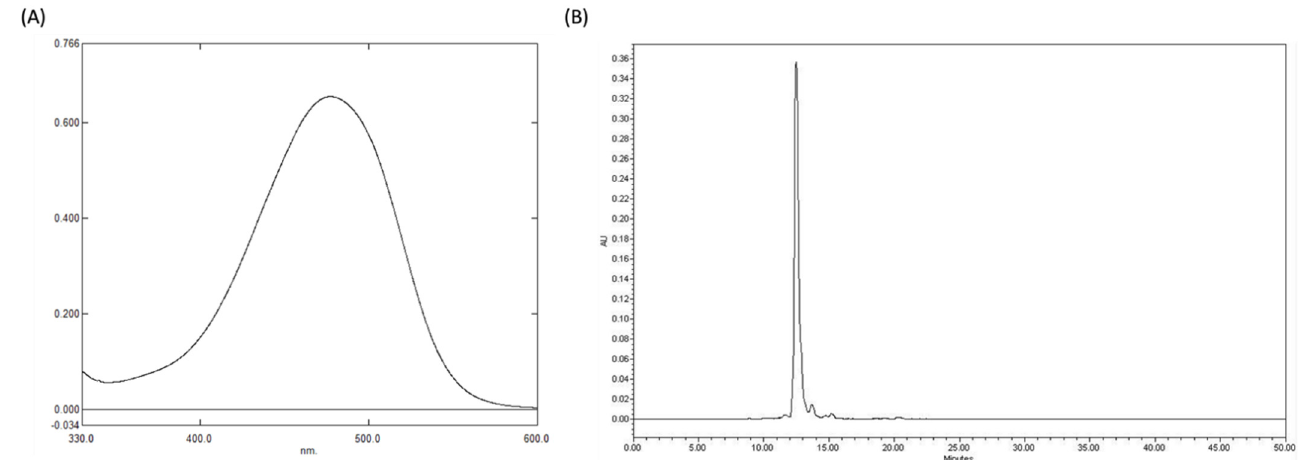
Figure 1. Validation of astaxanthin purity extracted and purified from the strain K. marxianus 6 − 13 − a6. ( A ) Evaluation of astaxanthin purity by UV spectrometer. ( B ) Evaluation of astaxanthin purity by HPLC.